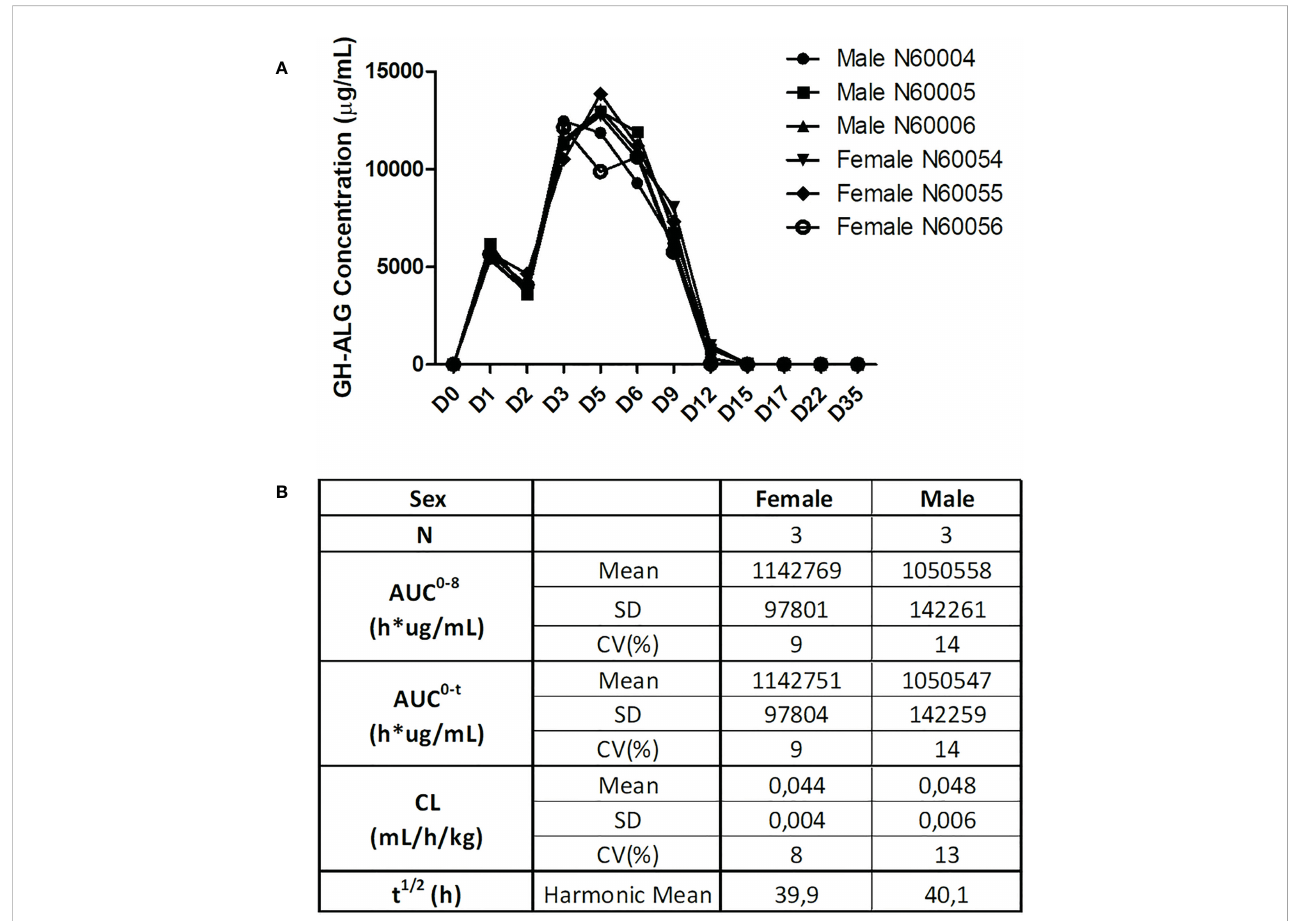
FIGURE 6 Pharmacokinetic evaluation. For the GH-ALG GLP toxicology study, one group of three male and three female cynomolgus monkeys received GH-ALG by daily intravenous administration (4-hour infusion) at 50 mg/kg/adm for 5 days. Serum samples were drawn on Days 1 (before infusion, 5 minutes, 24 and 96 hours after infusion) and 5 (before infusion and 5 minutes after infusion) and Days 6, 9, 12, 15, 17, and 22 and week 5. Pharmacokinetic parameters were analyzed by ELISA. (A) Pharmacokinetic pro fi les of GH-ALG-treated macaques. (B) Pharmacokinetic